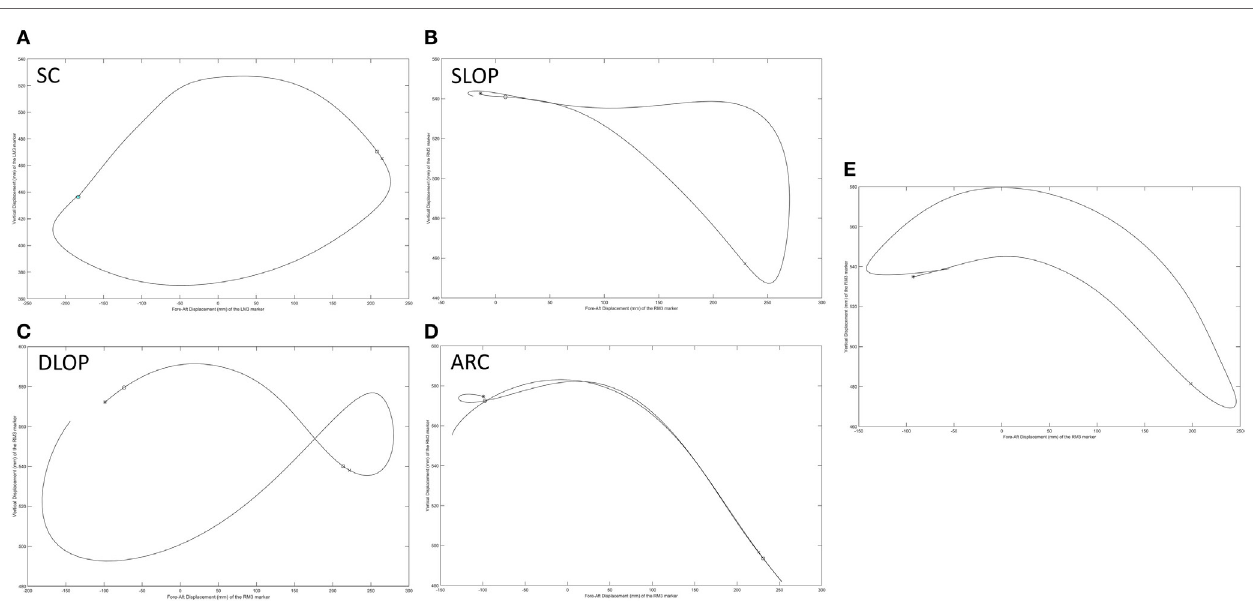
FigUre 12 | representative stroke patterns observed by individuals during the propulsion task . (a–D) Correspond to the four patterns previously identified and classified in adult users: (a) semicircular (SC), (B) single looping over propulsion (SLOP), (c) double looping over propulsion (DLOP), and (D) arcing (ARC). (e) Does not appear to readily fall into one of these